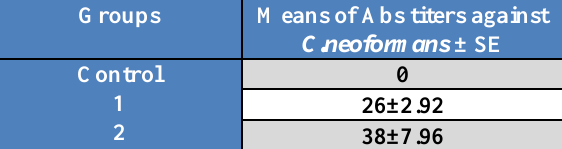
Table, 2: Shows mean thickness of skin against SSCAgs in immunized animals at 24-48hrs posttest. Groups after 24 hrs after 48 hrs Control 1